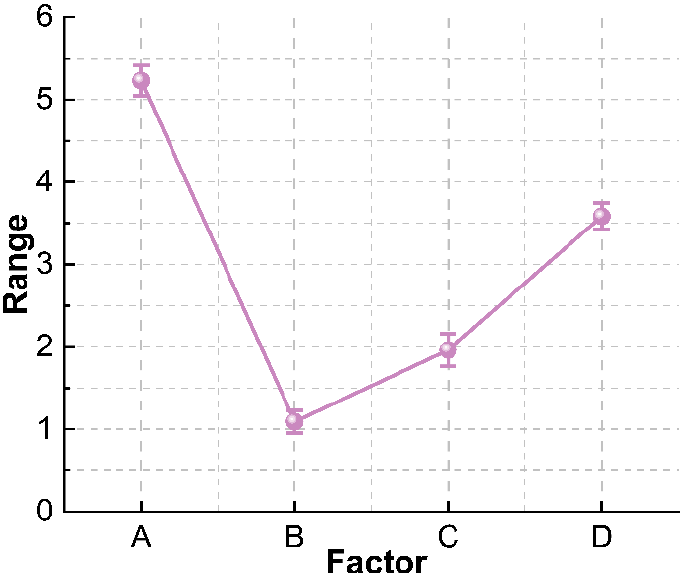
Figure 2. Analysis of the range of compressive strength of foam concrete.